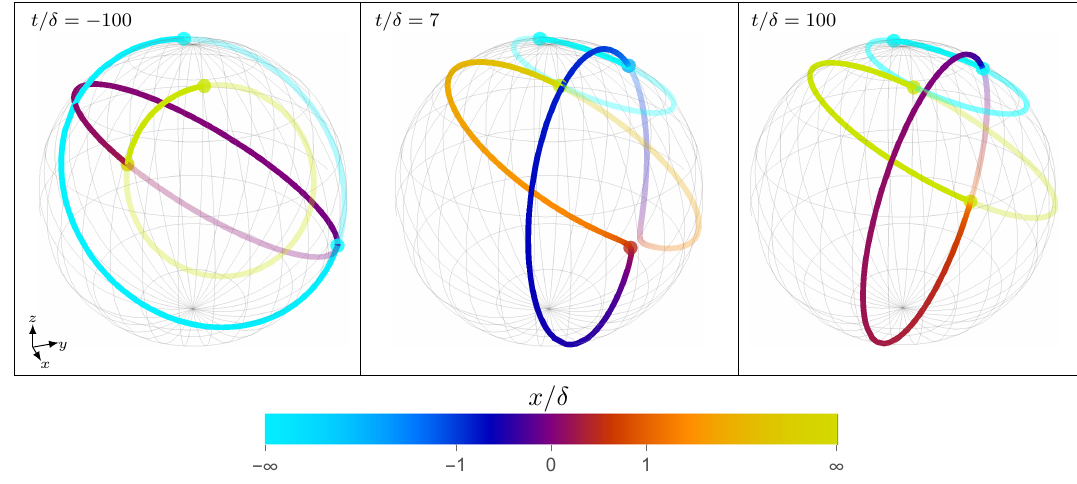
Figure 5 . The spin configurations u ( x, t ) (strong lines) and v ( x, t ) (weak lines) for the three-soliton solutions with initial data (6.35), at fixed times t/δ = 100 (far past and future) and t/δ = 7 when ± all solitons are well-separated. The individual rotation circles of the solitons are clearly visible. The colored dots indicate the local vacua m − = m −∞ , m + for j = 1 , 2 , and m + = m + ∞ . The m − j ≈ j +1 1 3 orientation of all three plots is the same, as indicated by the coordinate system in the bottom left corner of the first plot. The color of the image on S 2 indicates the value of x according to the legend underneath. Note that, at t/δ = 7 , solitons 2 and 3 are not as well-separated as the others and, therefore, the two circles at m + (indicated by the red dot) do not m − 2 ≈ 3